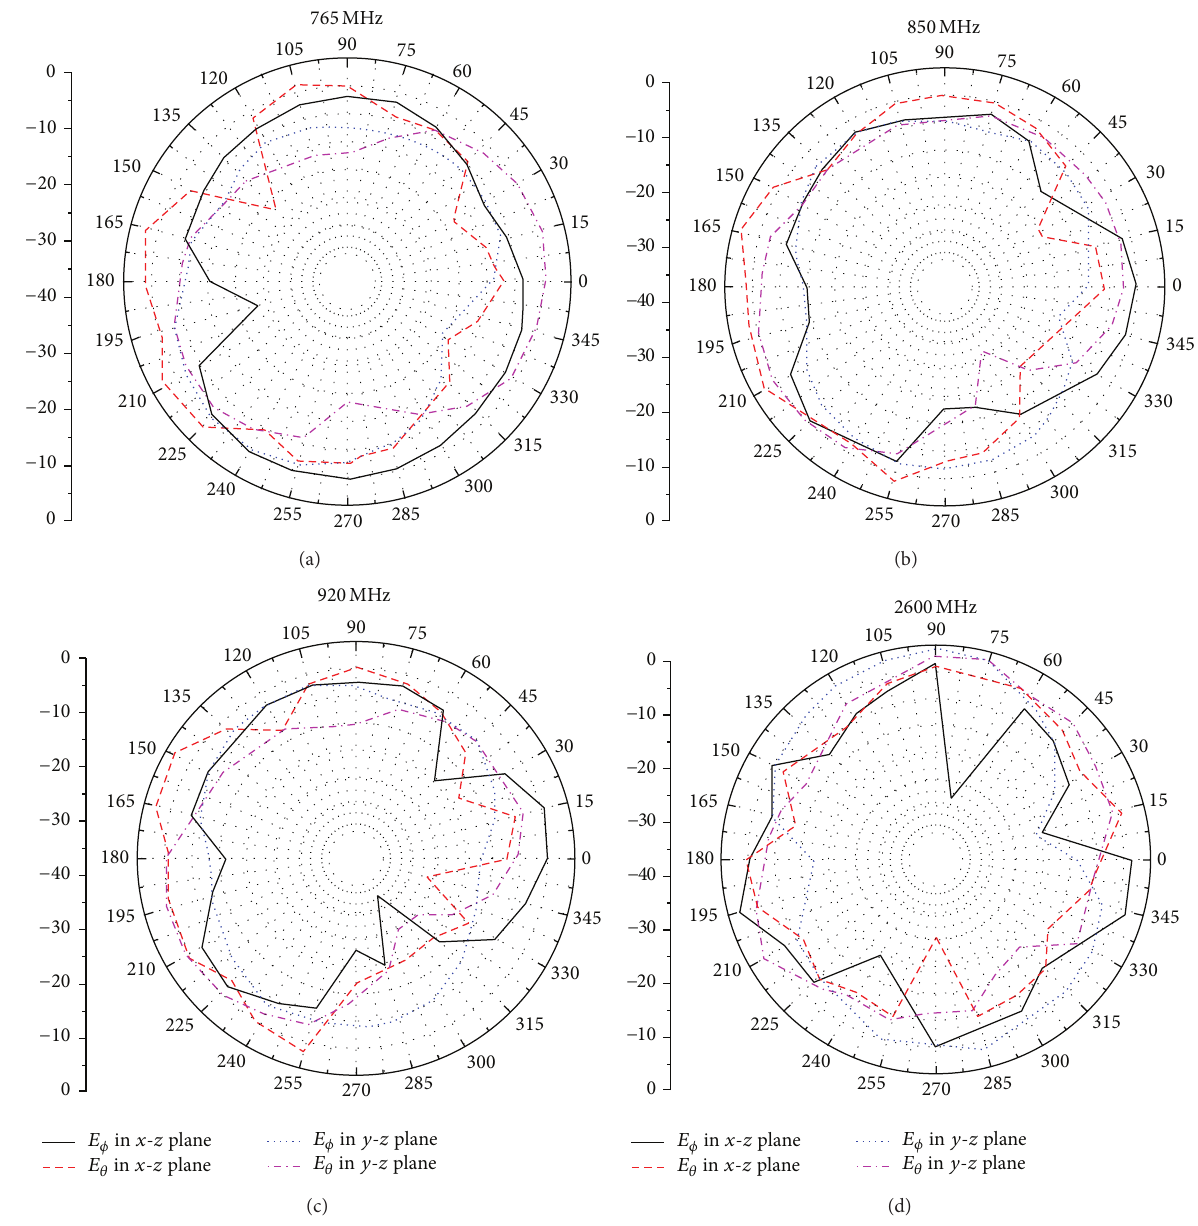
Figure 8: Measured two-dimensional radiation patterns of antenna 1 in the MIMO